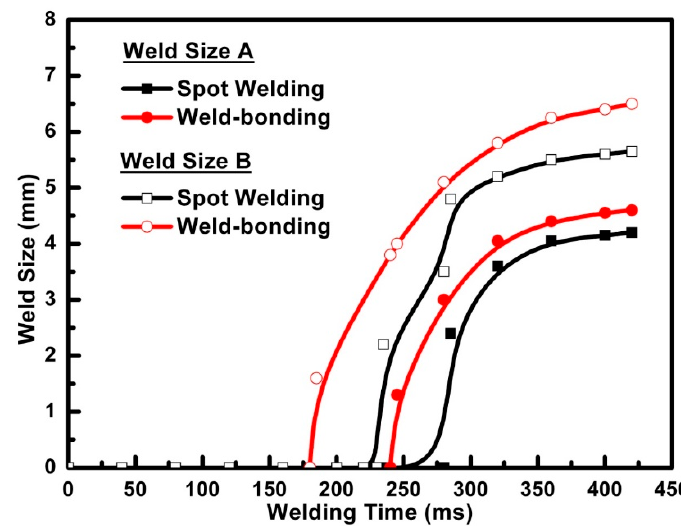
Figure 13. Comparison of the weld nugget formation between the weld-bonding and the spot welding.